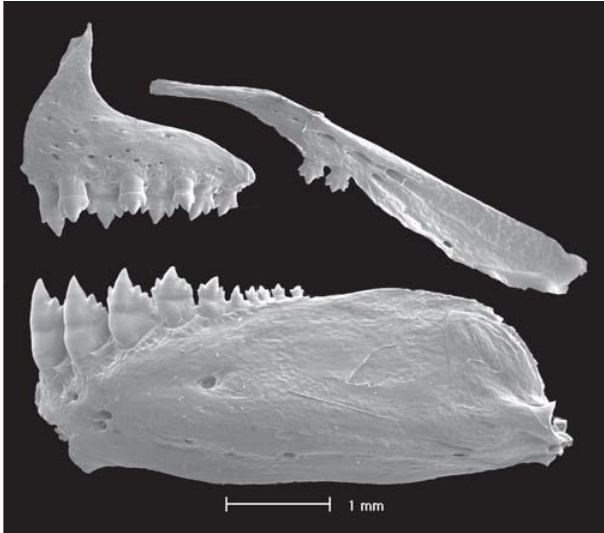
Fig. 3. Astyanax microschemos , MCP 34366, paratype, 46.3 mm SL. SEM image of left side upper and lower jaws